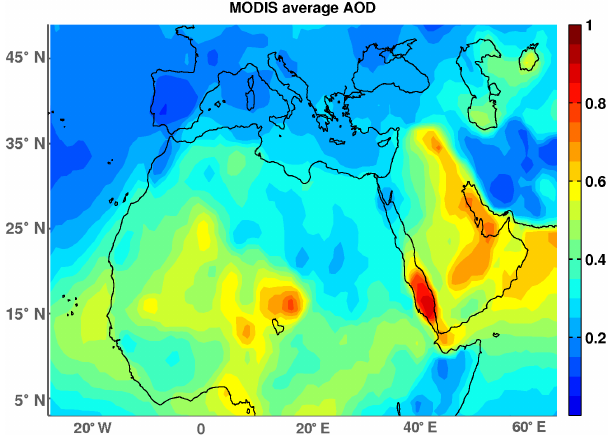
Figure 2. MODIS AOD observations within the simulation domain, averaged for the whole 6-month period, i.e. 1 March to 31 Au- gust